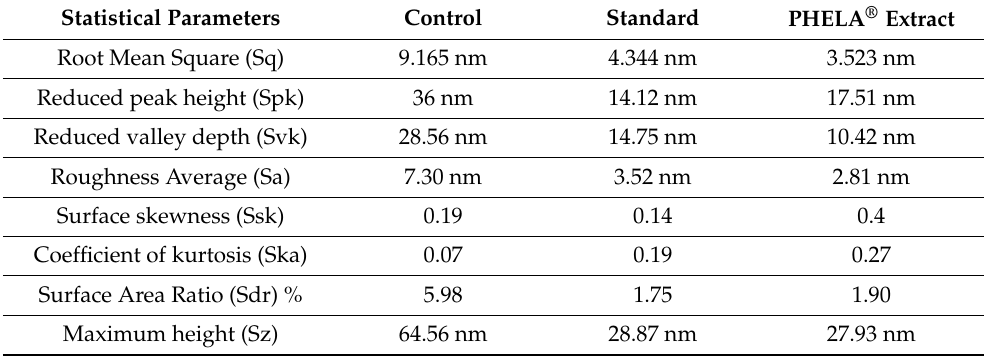
Table 4. Statistical parameters for AFM